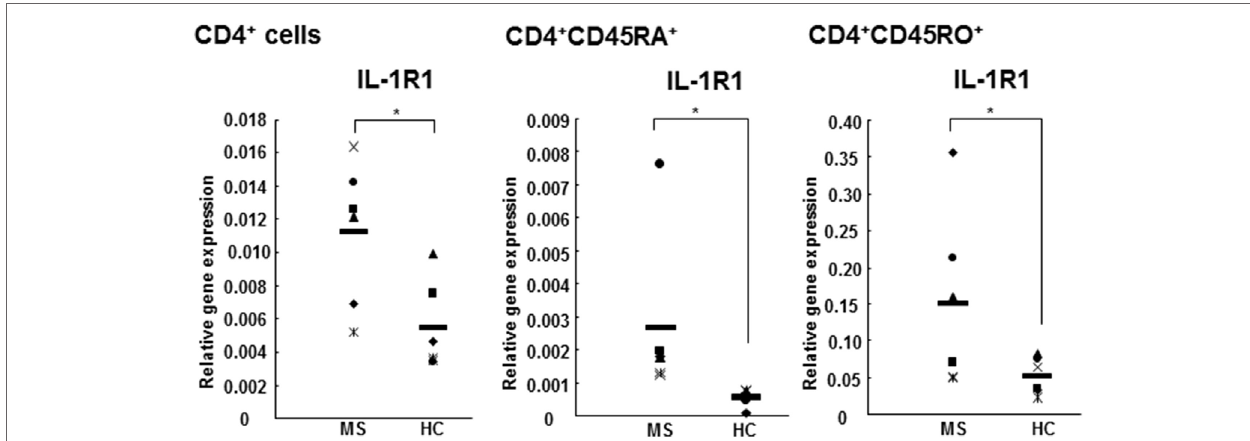
FigUre 1 | il-1ri gene expression is increased in cD4 + , cD4 + cD45ra + , and cD4 + cD45rO + cells from rr Ms patients in comparison to hcs . CD4 + , CD4 + CD45RA + naive, and CD4 + CD45RO + memory T cells derived from six RR MS patients and six HCs were separated using magnetic beads. The total RNA was harvested and the gene expression of IL-1RI and 18S was measured using qRT-PCR. The results are presented as the relative gene expression normalized against 18S mRNA. Statistical analysis was performed using unpaired t